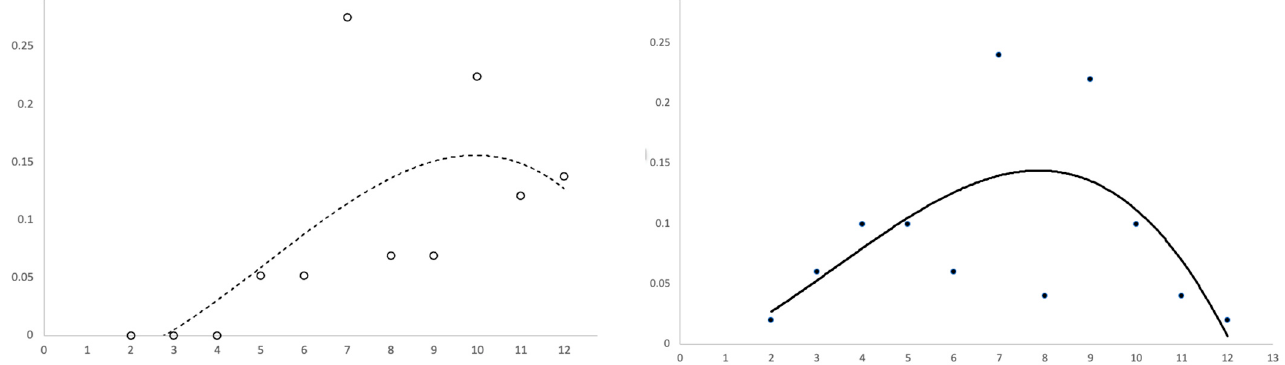
Figure 3. Cartesian scatter plots reporting control event rate (CER, left plot) or experimental event rate (EER, right plot) on the vertical axis, by days since initial positive and first negative swab test result against SARS-CoV-2 (horizontal axis). The two (dotted and continuous) lines represent a third degree polynomial function.